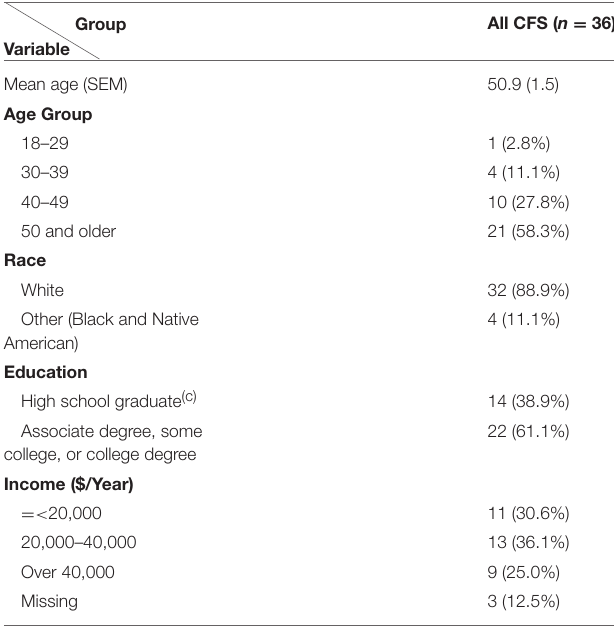
TABLE 1 | Demographic characteristic for the sample of 36 women with chronic fatigue syndrome (CFS cases) in the case-control study of chronic fatigue syndrome, Wichita, USA,